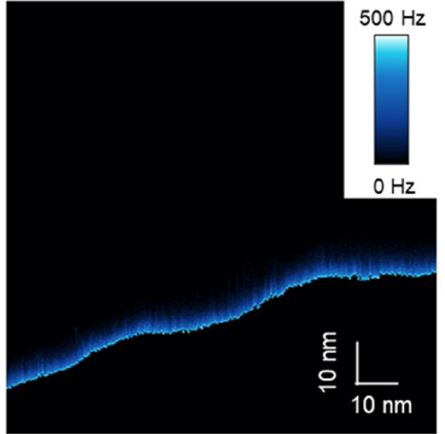
Figure 11. FM-AFM z-scan image on the HUVEC/PBS interface.